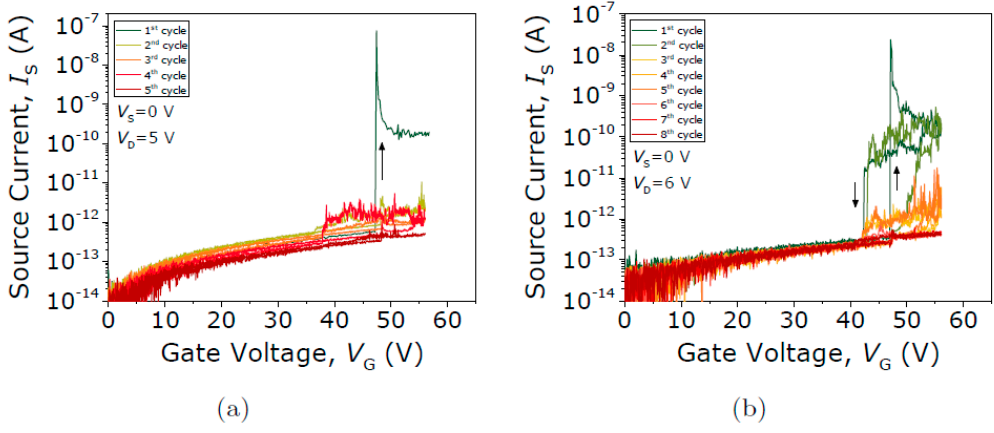
Figure 12. Successive current voltage ( I-V ) curves in air from the ( a ) left contact and ( b ) right contact of the Type III seesaw relay.